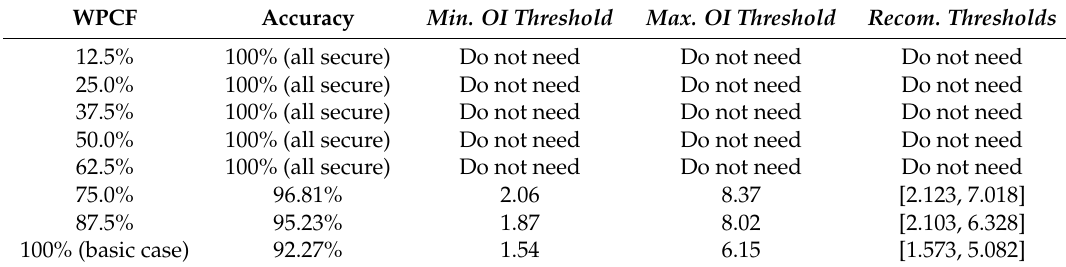
Table 2. Sensitivity analysis in the context of renewable energy penetration